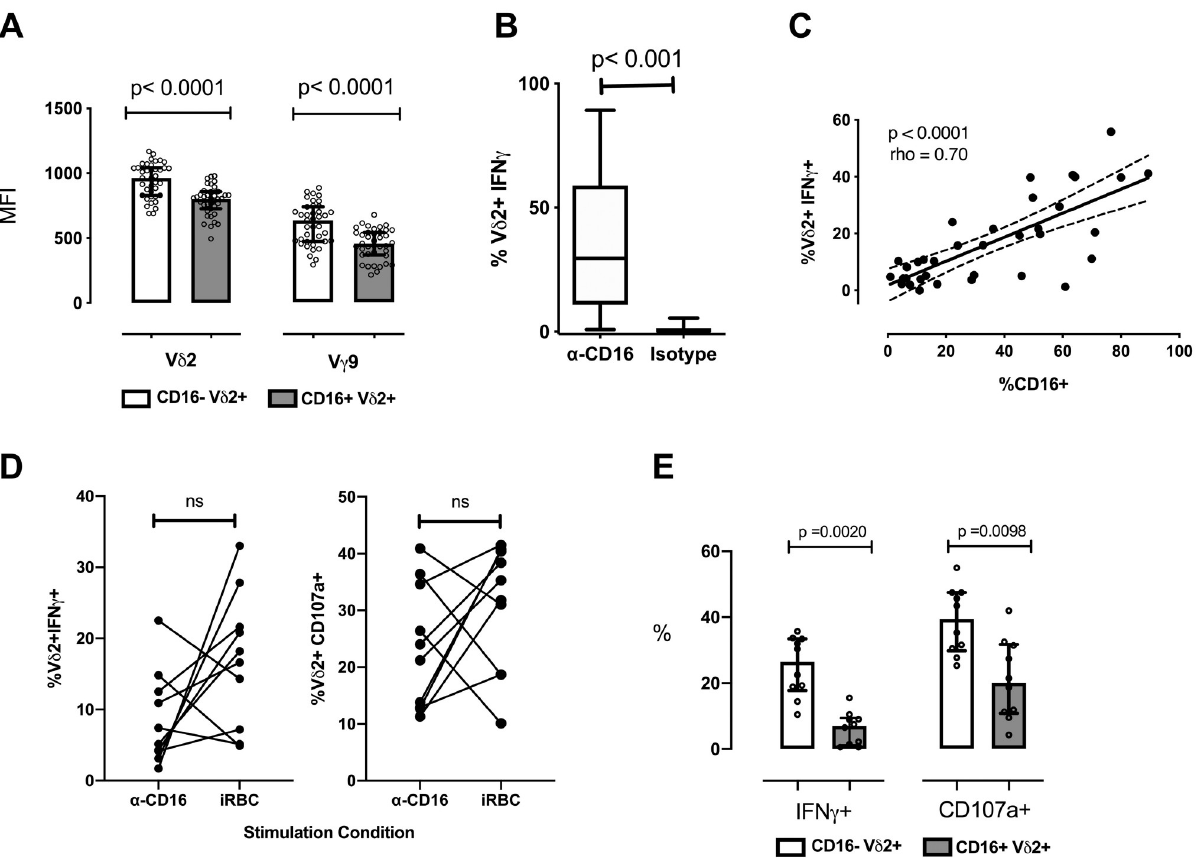
Fig 2. CD16+ V δ 2 T cells from malaria-exposed individuals downregulate TCR and can be independently stimulated through CD16. (A)The MFI of the V δ 2 and V γ 9 chains is shown for CD16+ and CD16- V δ 2+V γ 9+T cells. Data points and accompanying p-value are paired. (n = 39; scatter plots with median and IQR). (B) The percentage of V δ 2 T cells producing IFN γ in response to anti-CD16 crosslinking antibody or isotype is compared (n = 35; box plots with median and Tukey whiskers). (C) The percentage of V δ 2 T cells producting IFN γ in response to plate-bound anti-CD16 crosslinking antibody is graphed against the percentage of V δ 2 T cells expressing CD16 prior to stimulation (n = 35). (D) The percentage of V δ 2 T cells positive for IFN γ or CD107a after stimulation with anti-CD16 crosslinking antibody or iRBC is compared (n = 10) (E) V δ 2 T cells positive for IFN γ or CD107a after iRBC stimulation from the experiment in E are grouped by CD16 expression. All V δ 2+ T cells shown were gated on singlets and CD3 + events to exclude NK cells. P values determined by Wilcoxon matched pairs signed rank test in A, B, D and D, and with Spearman correlation in